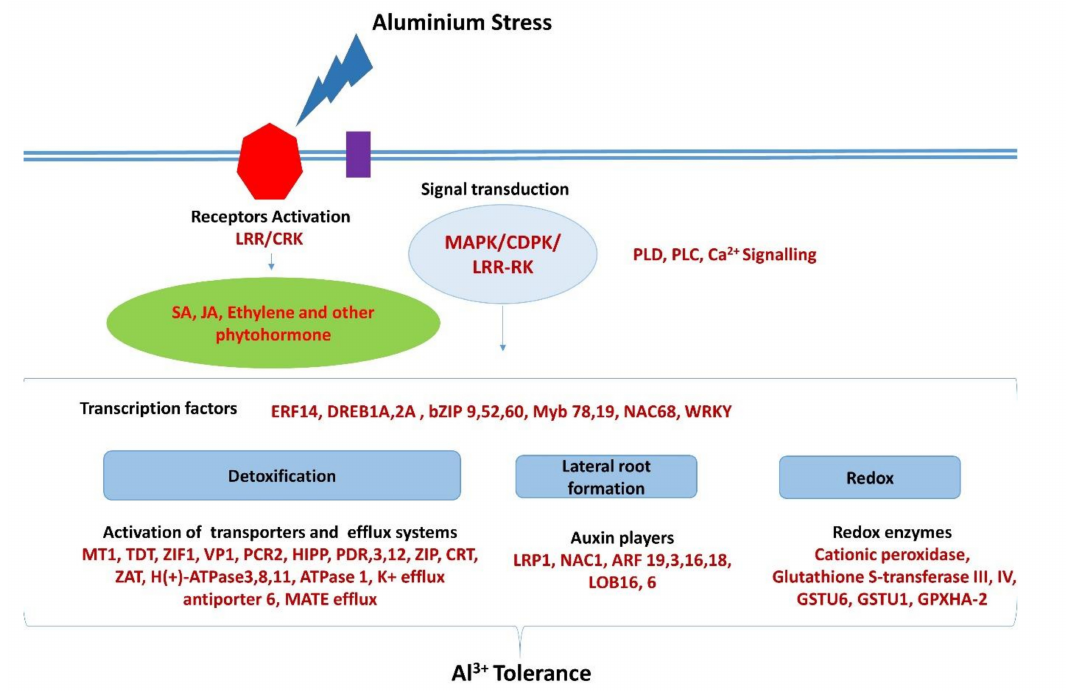
Figure 9. Hypothetical model for aluminum tolerance in TAS. Genes in red are